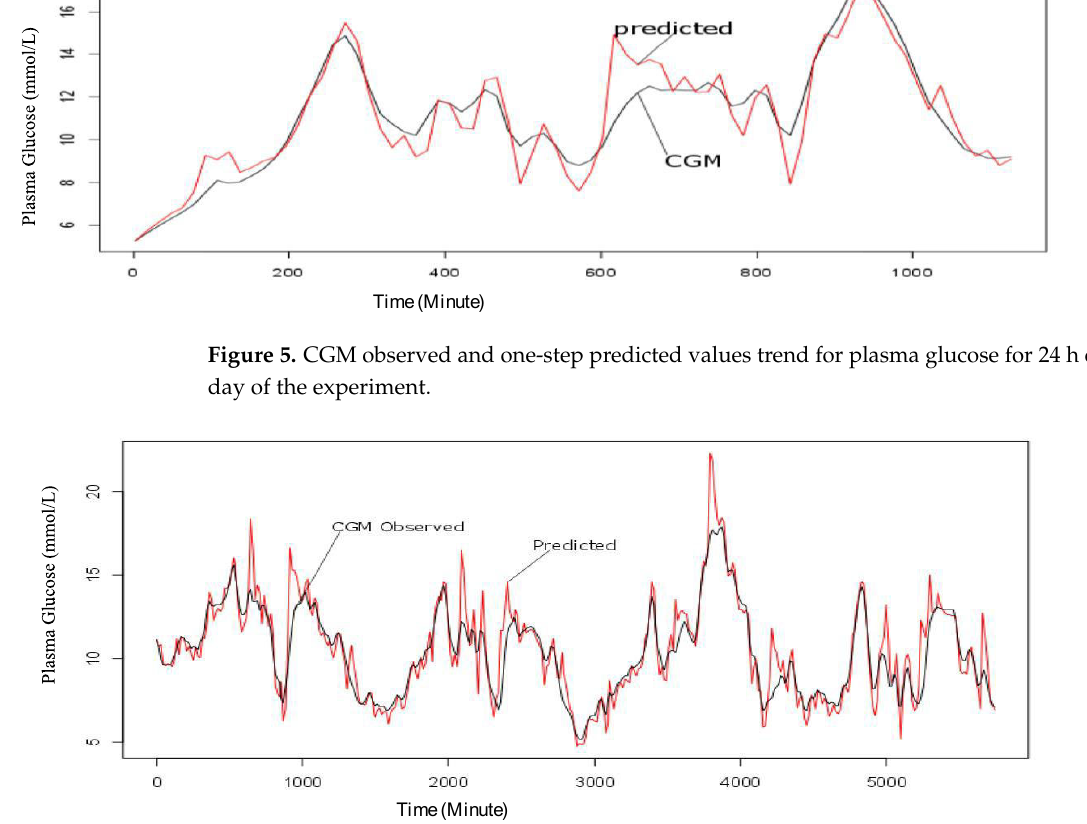
Figure 6. CGM observed and one-step predicted values trend for plasma glucose for four consecutive days.